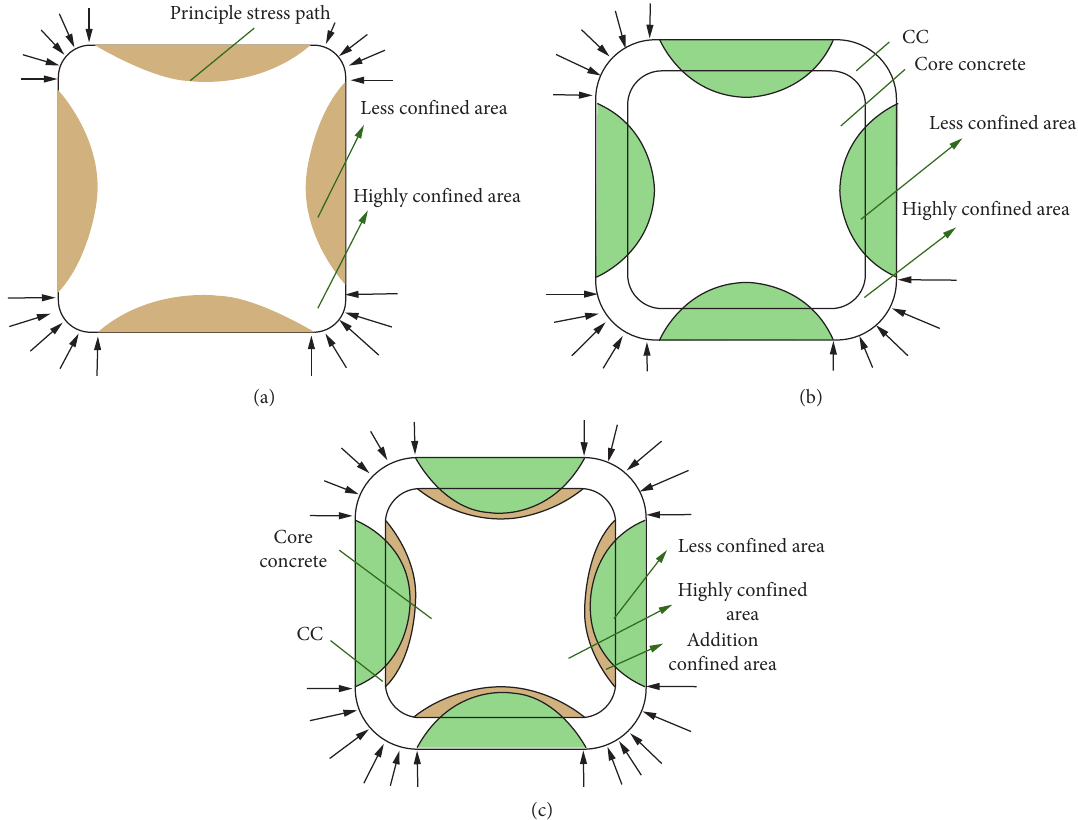
Figure 10: Schematic diagram of the confined area with different methods. (a) CFRP-reinforced column. (b) CFRP and concrete canvas- reinforced column. (c) The different confined areas with the two reinforced